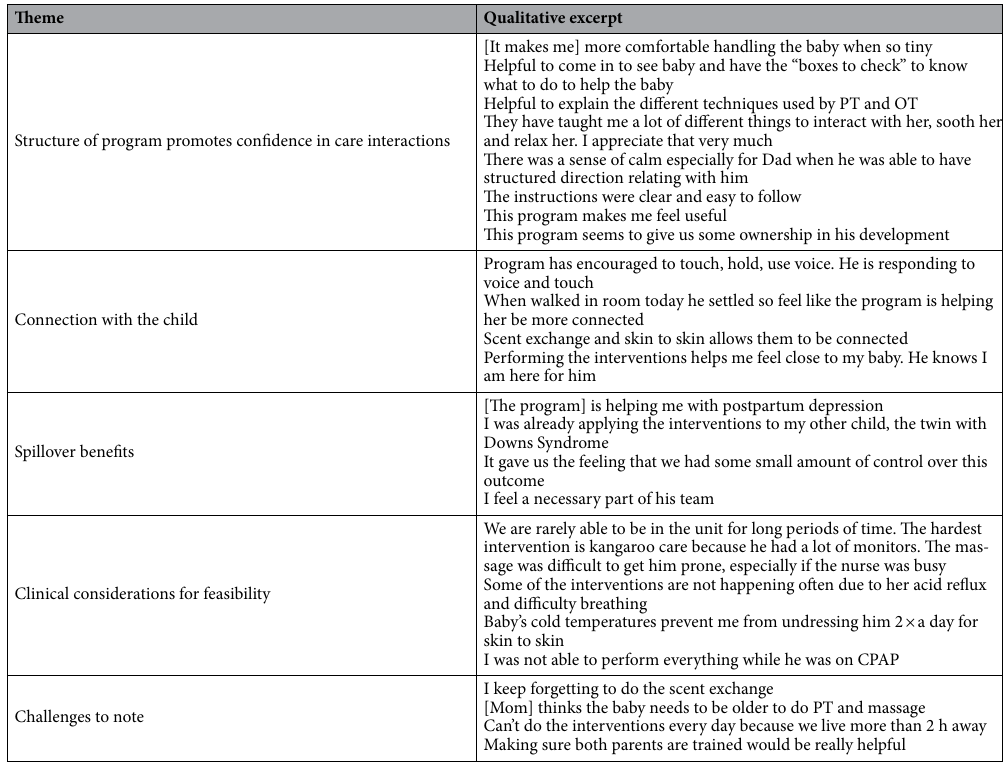
Table 4. Qualitative findings related to acceptability and feasibility of the